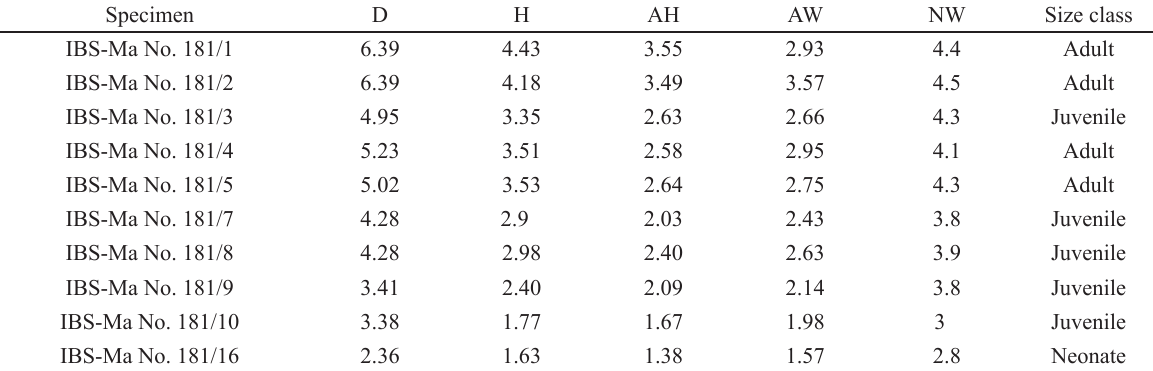
Shell measurements of Ovachlamys fulgens taken on ten specimens from Eldorado city in the Misiones province of northeastern Argentina.